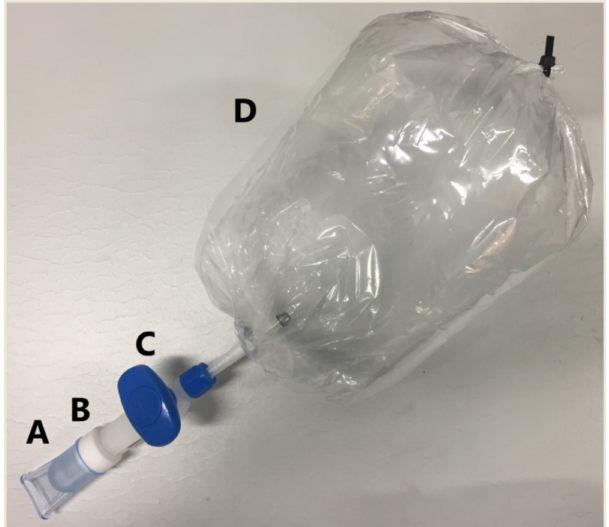
Figure 2. Breath sampling system composed of ( A ) disposable mouthpiece, ( B ) non-return valve, ( C ) two-way valve, and ( D ) Nalophan